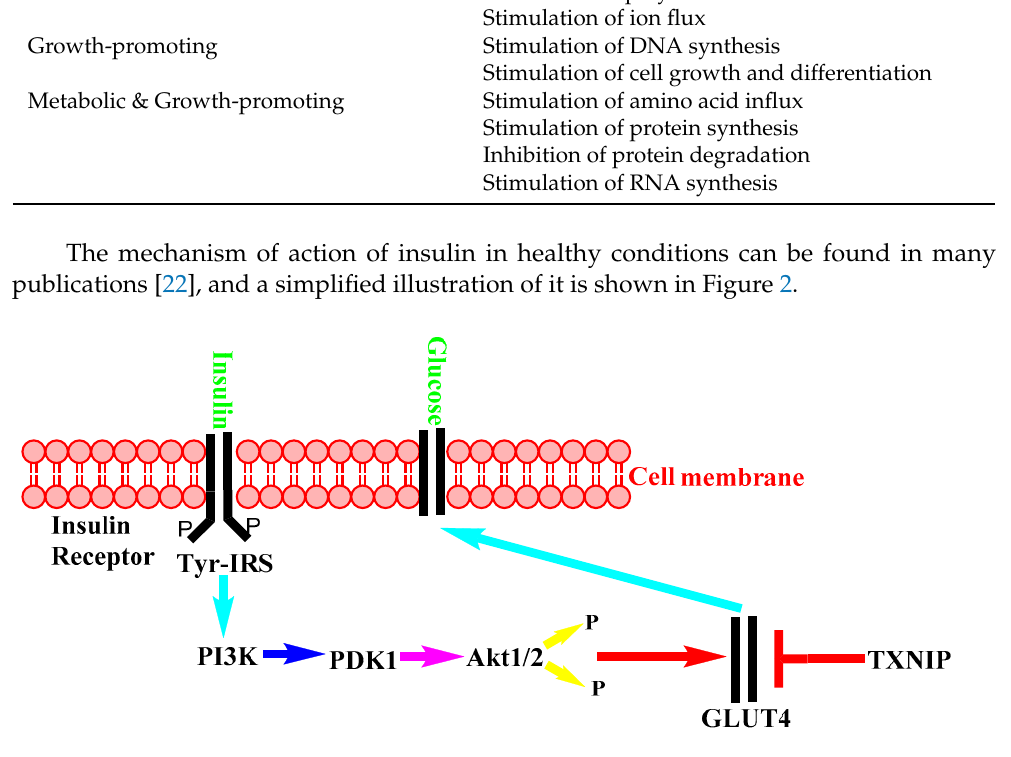
Figure 2. Insulin mechanism of action in healthy conditions.